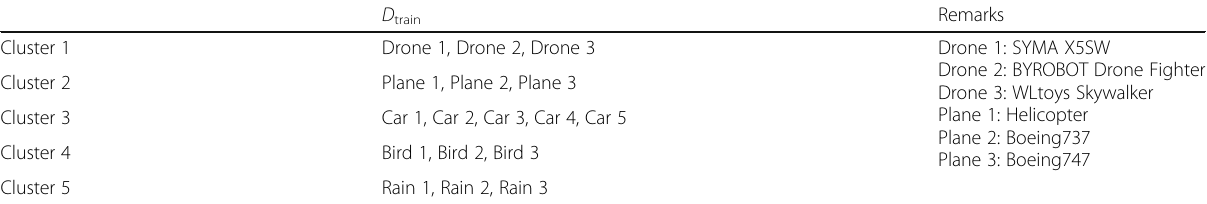
Table 1 Five clusters of sounds in the training dataset